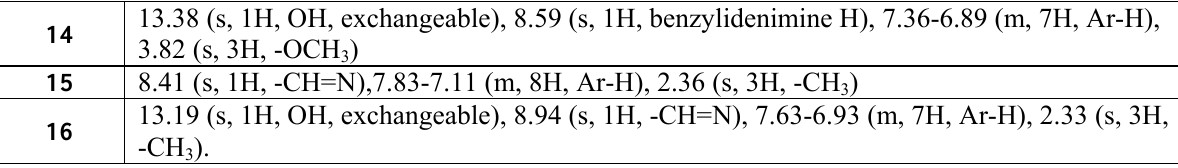
Table 3. 13 C-NMR (DMSO-d